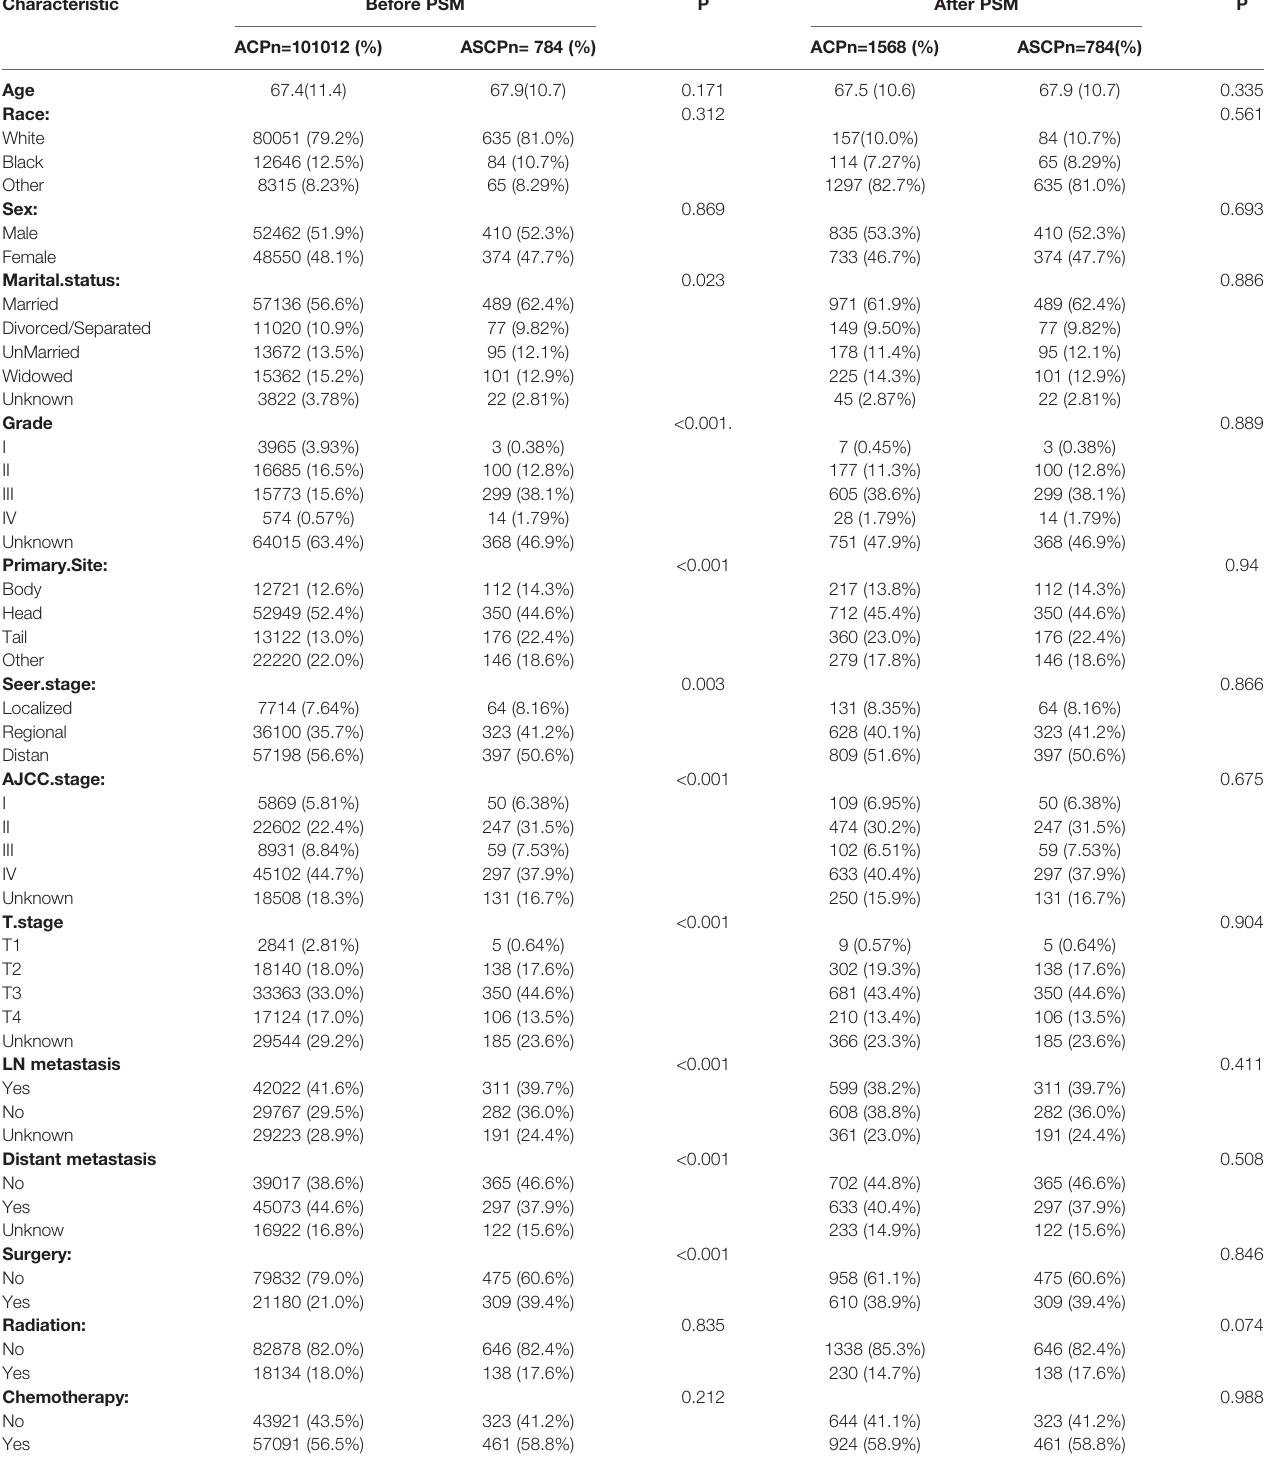
TABLE 1 | Comparison of clinicopathological characteristics between ASCP and ACP.